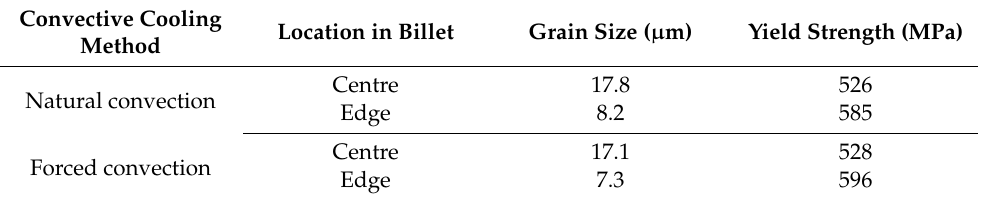
Table 4. Predicted yield strength of different parts of the billets, for different convective cooling, based upon the Hall–Petch